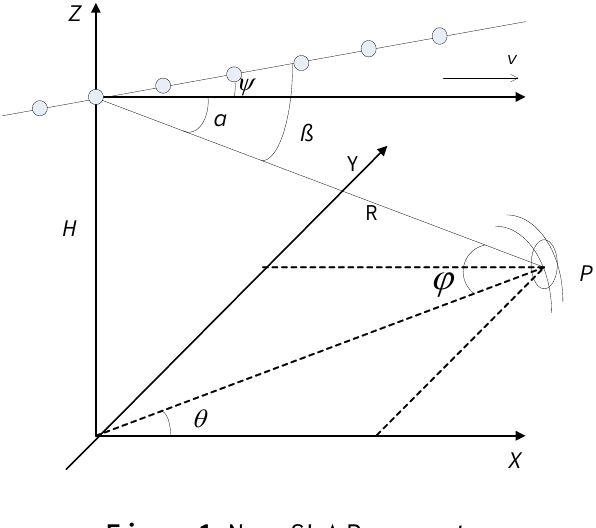
Figure 1. Non-SLAR